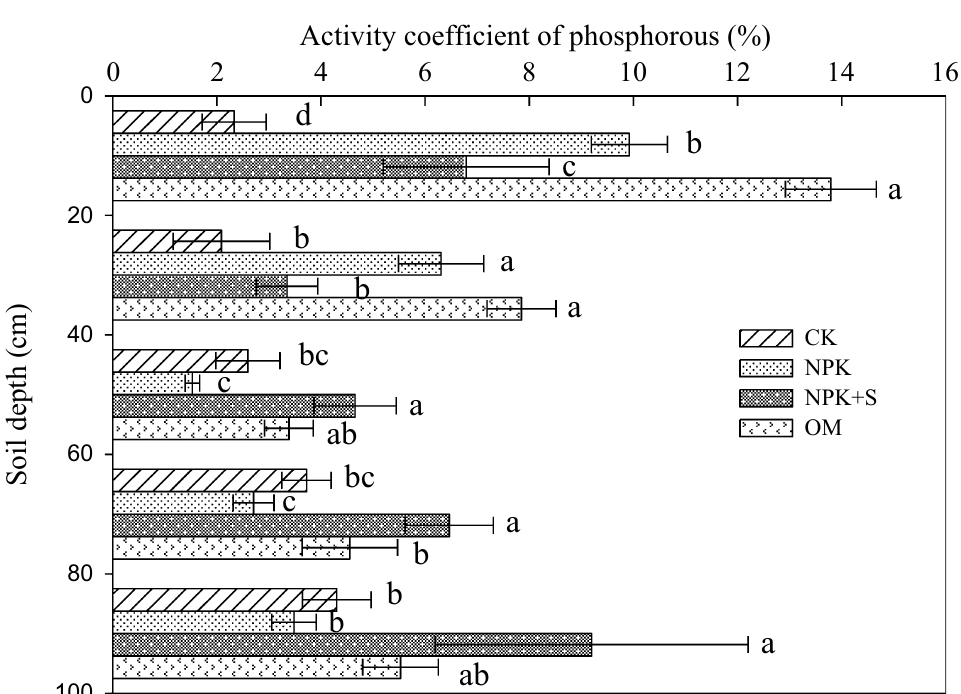
Figure 3. Effect of long-term fertilization on phosphorous activation constant in Mollisol profiles. Different letters in the bars of same depth indicates significant difference at P < 0.05 level among different treatments. CK, no fertilizer application; NPK, chemical fertilizer application; NPK + S, chemical fertilizer plus maize straw incorporation; OM, organic manure